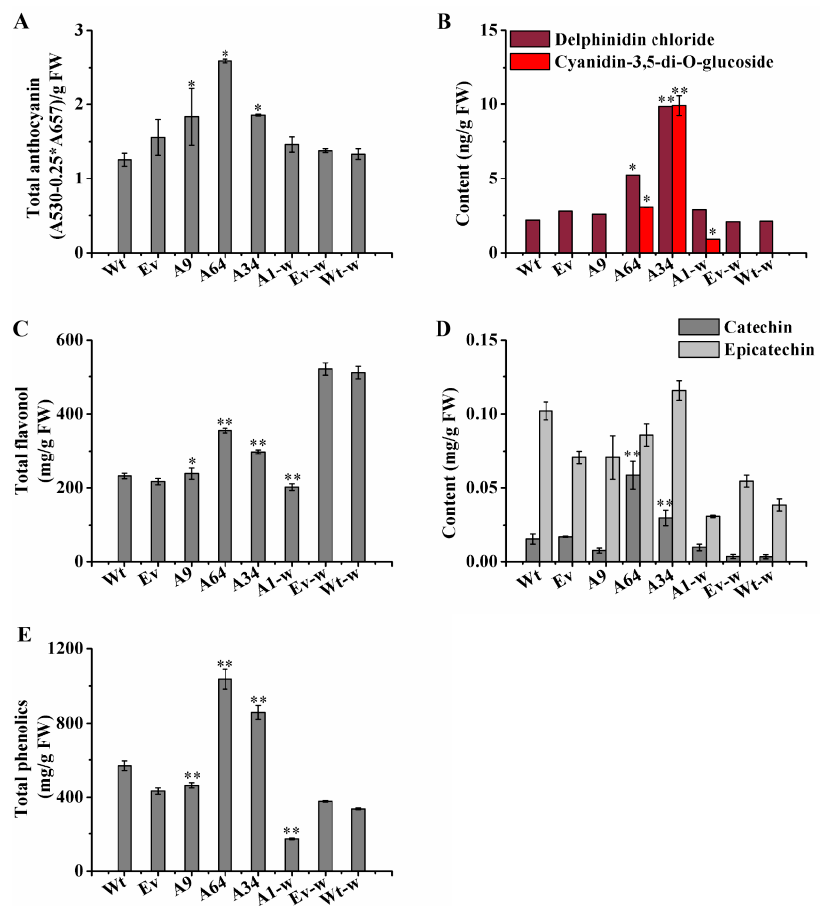
Figure 5. Analysis of flavonoids and total phenolics in transgenic lines. ( A ) The content of total anthocyanin in controls and transgenic lines; ( B ) The contents of delphinidin and cyaniding 3,5-di- O -glucoside in controls and transgenic lines; ( C ) The content of total flavonoid from controls and transgenic lines; ( D ) The contents of catechin and epicatechin analyzed by HPLC; ( E ) Total phenolics content from controls and transgenic lines. Wt, the controls that were untransformed wild S. miltiorrhiza plants. Ev, the controls that only transformed the empty vector in S. miltiorrhiza . A9, A64, and A34, three transgenic lines of SmANS -overexpressed in S. miltiorrhiza . A1-w, transgenic line of SmANS -overexpressing in S. miltiorrhiza Bge f. alba . Ev-w, the controls that only transformed the empty vector in S. miltiorrhiza Bge f. alba . Wt-w, the controls that were untransformed wild S. miltiorrhiza Bge f. alba plants. FW, fresh weight. The vertical bars show the SD values from three independent biological replicates. (*) indicated a significant di ff erence (0.01 < p < 0.05). (**) indicated a very significant di ff erence ( p < 0.01).